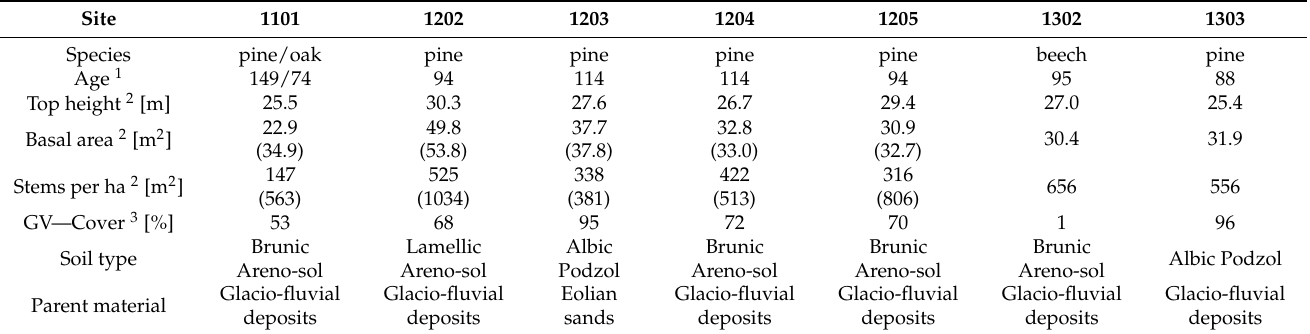
Table 1. Stand and site characteristics, with pine = Scots pine ( Pinus sylvestris ), oak = Pedunculate oak ( Quercus petraea ), and beech = European beech ( Fagus sylvatica ). Values for basal area and stems per ha are for the dominant tree layer (in brackets for the total stand). GV—Cover = Cover of ground vegetation